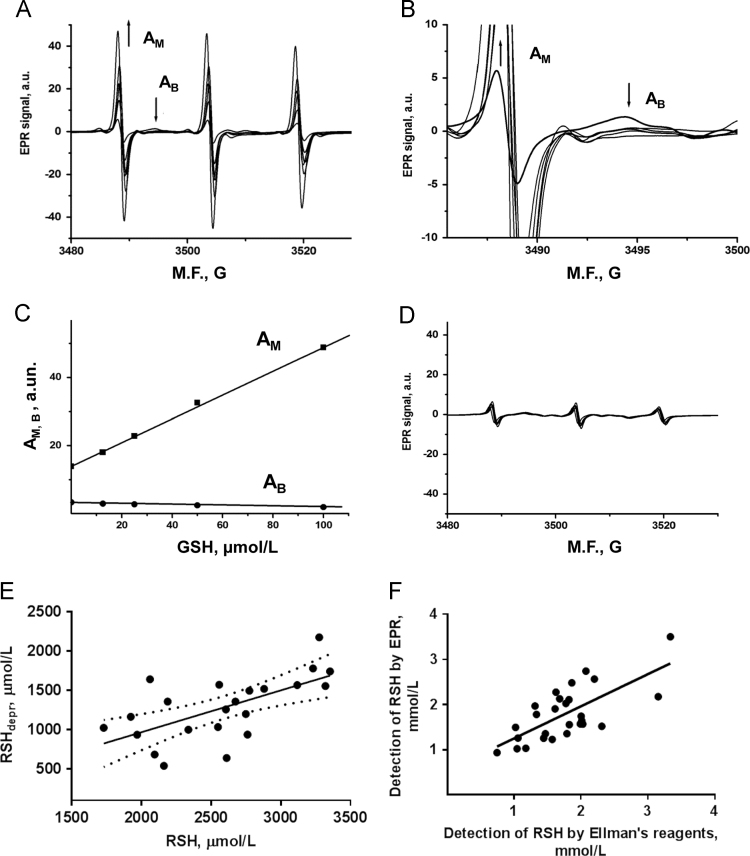
Measurement of reduced thiol concentrations. A. Typical EPR spectra and the low-field spectrum components (B) of the biradical spin probe (200 µmol/L) in presence of increased GSH concentrations; AM is a signal component associated with monoradical nitroxide, AB - with biradical [1]. C. Calibration curve for the quantification of reduced thiol concentrations from the EPR spectra using peak-to-peak amplitude of the AM component (R=0.99; P<0.001; n=5). D. EPR spectra of the biradical nitroxide recorded in erythrocytes after addition of a SH-group blocker (N-Ethylmaleimide, 3 mM). E. Concentrations of reduced thiols in deproteinized RBCs versus RSH concentrations before deproteinization (R2=0.4, P=0.002; n=22). F. RSH concentrations in deproteinized RBCs measured by EPR versus the colorimetric assay using Ellman׳s reagent (R2=0.5; P<0.0001; n=27).